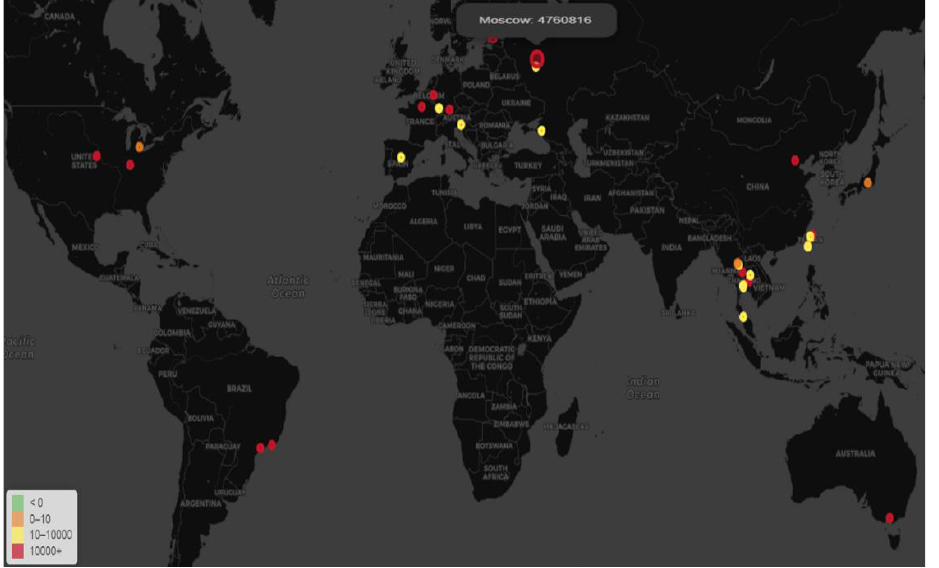
Figure 1. Geolocation representation of the unroutable LHCONE packet